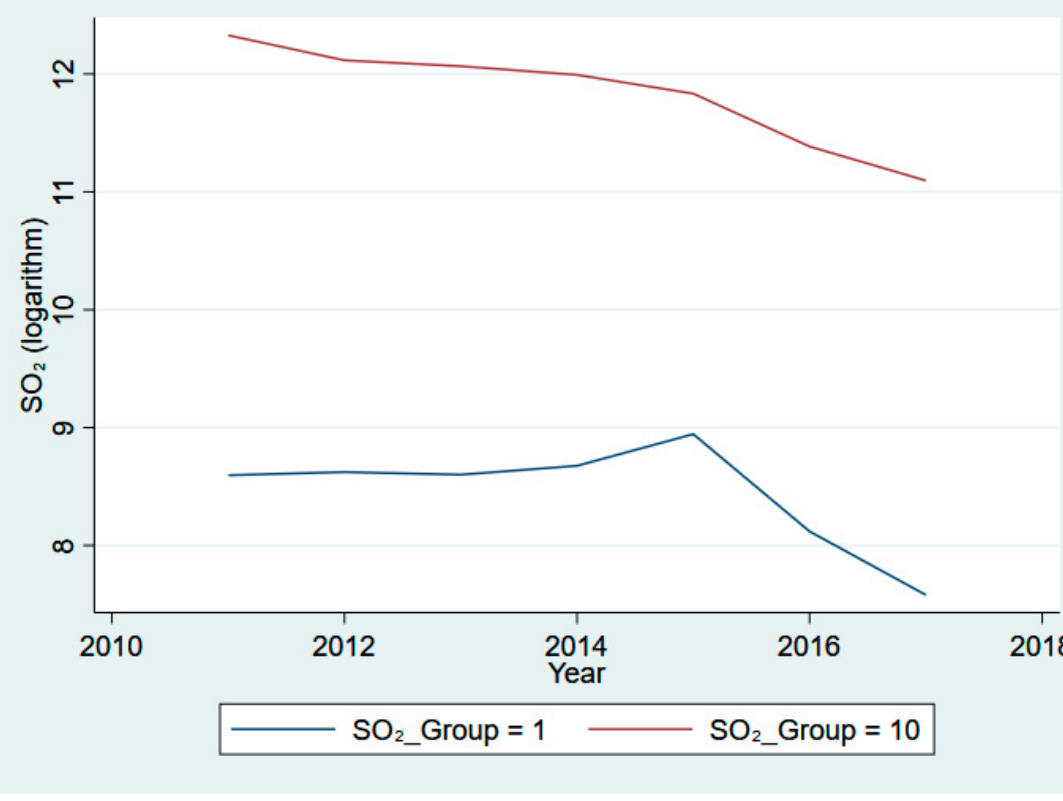
Figure 2. SO (cid:2870) emissions for 1st and 10th groups, 2011–2017.